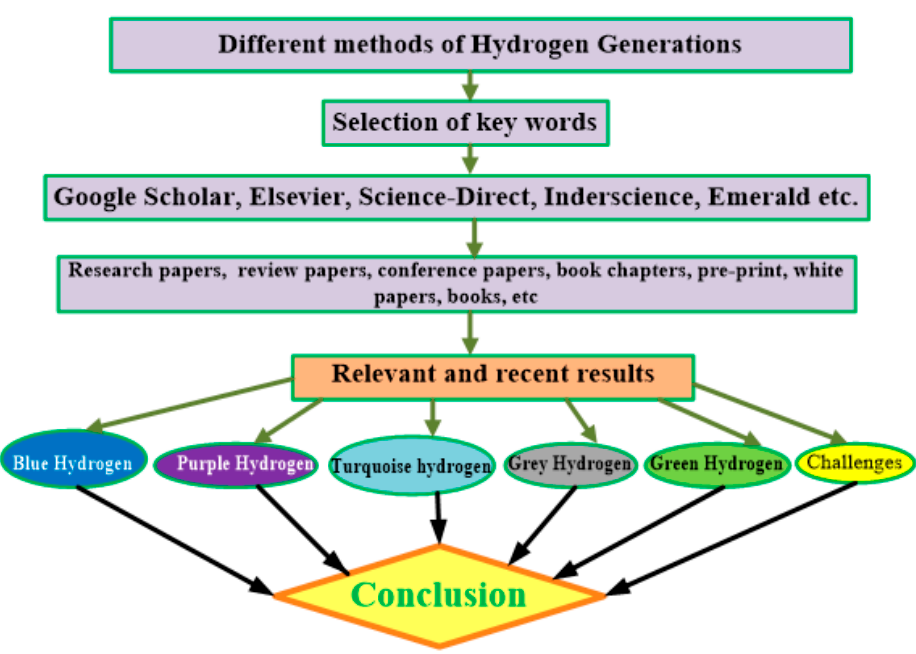
Figure 3. Schematic methodology of the review.